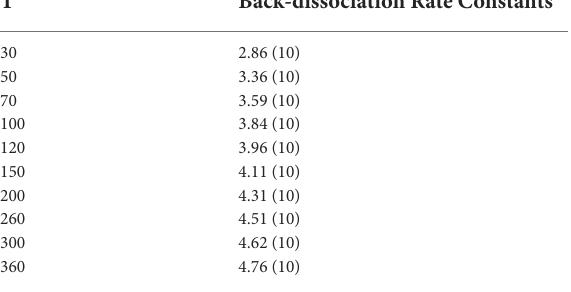
TABLE 4 Numerical values of the rate constants obtained in the present work for the back dissociation to pyridine (addition to the